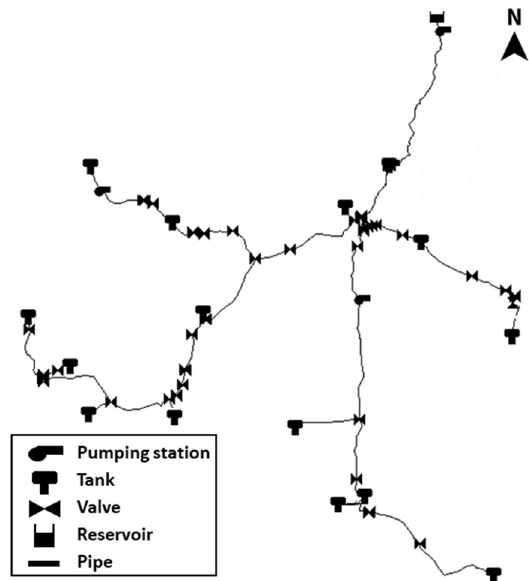
Figure 5. Hydraulic model elements.